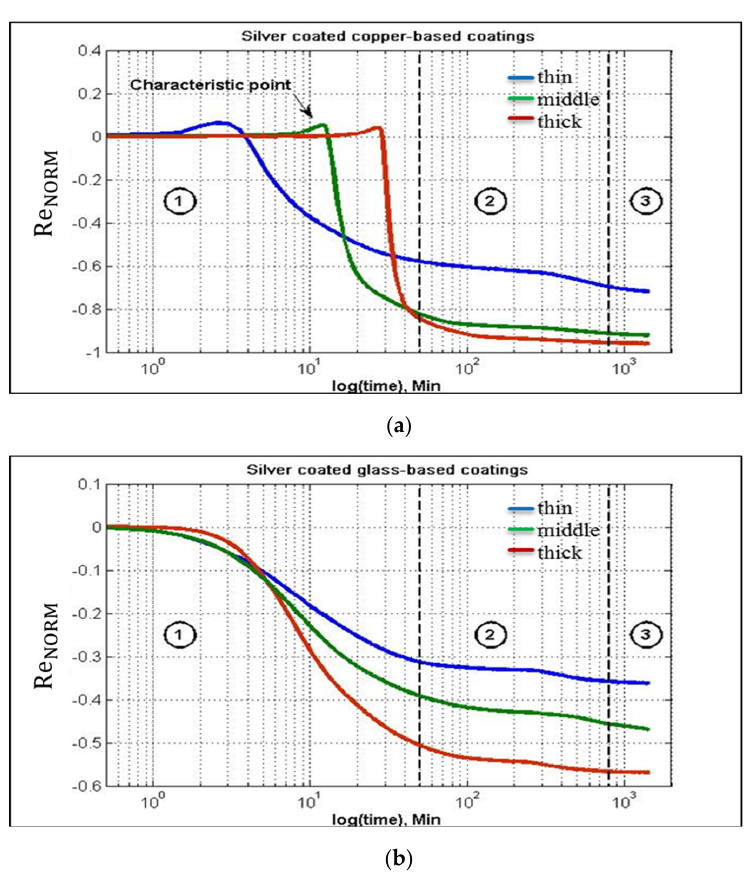
Figure 7. Experimental results of the HFEC measurements on Cu/Ag ( a ) and glass/Ag ( b ) films at a frequency of 10 MHz.